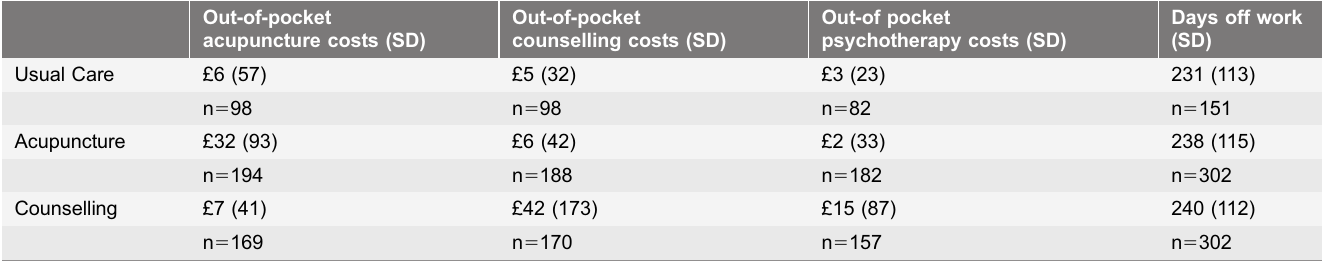
Table 4. Out-of-pocket costs and days of work for complete cases. Out-of-pocket acupuncture costs